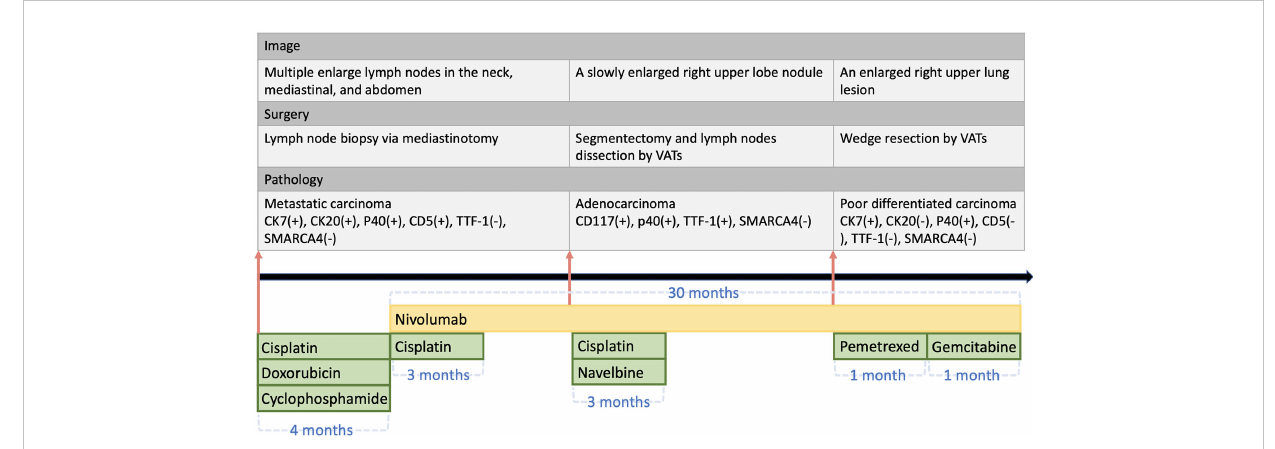
FIGURE 1 Timeline of the clinical course of the